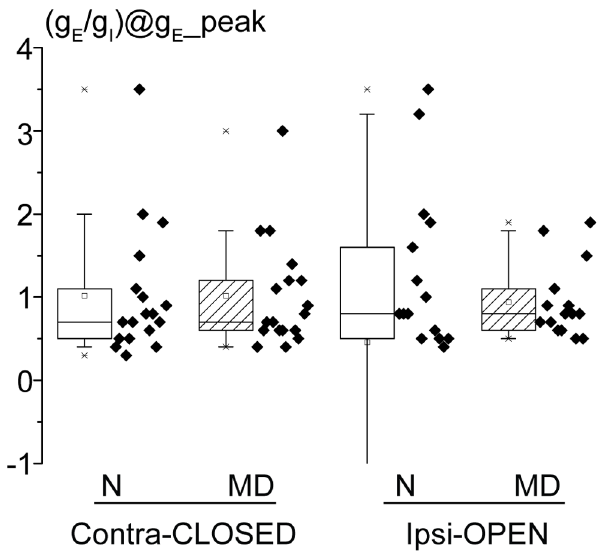
Figure 4. MD does not alter the ratio of excitation and inhibition measured at the excitation peak. The values of the ratio between g E and g I measured at the peak of the excitatory conductance are plotted for each experimental group. MD does not significantly modify the ratio values for both contralateral (left) and ipsilateral (right) eye responses (Mann-Whitney Rank Sum tests, p .